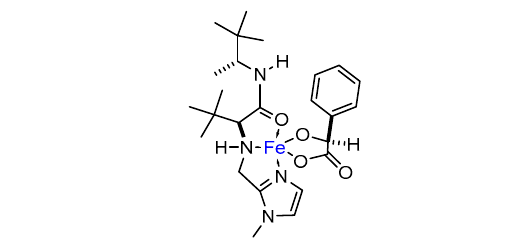
Figure 7. Possible coordination complex participating as catalyst in the model epoxidation reaction.